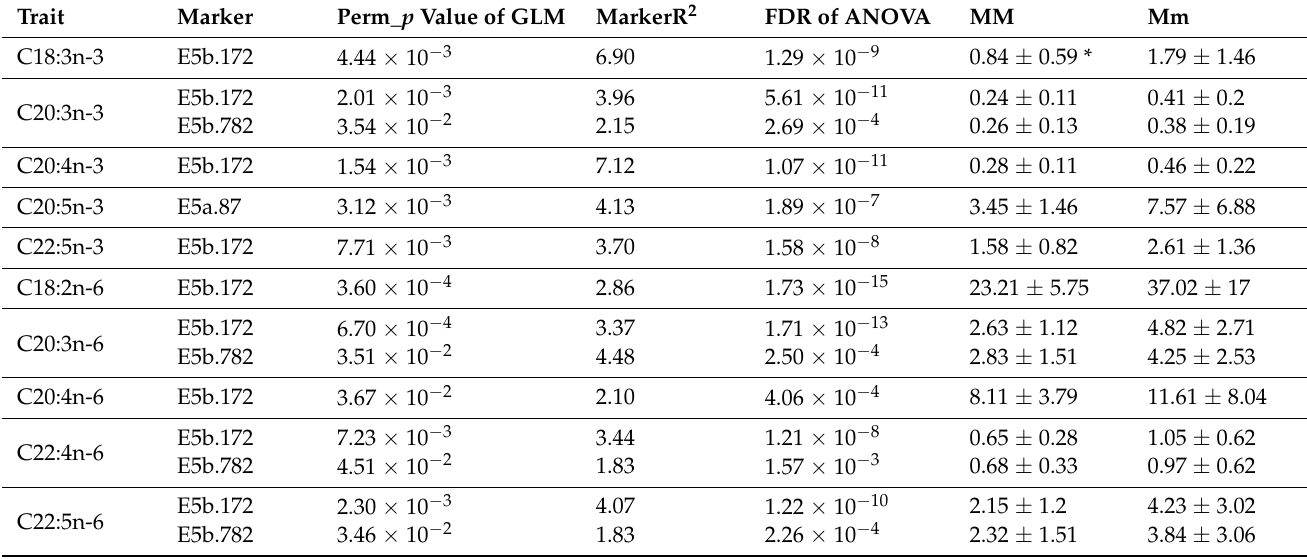
Table 2. Association analysis of the PUFA contents in common